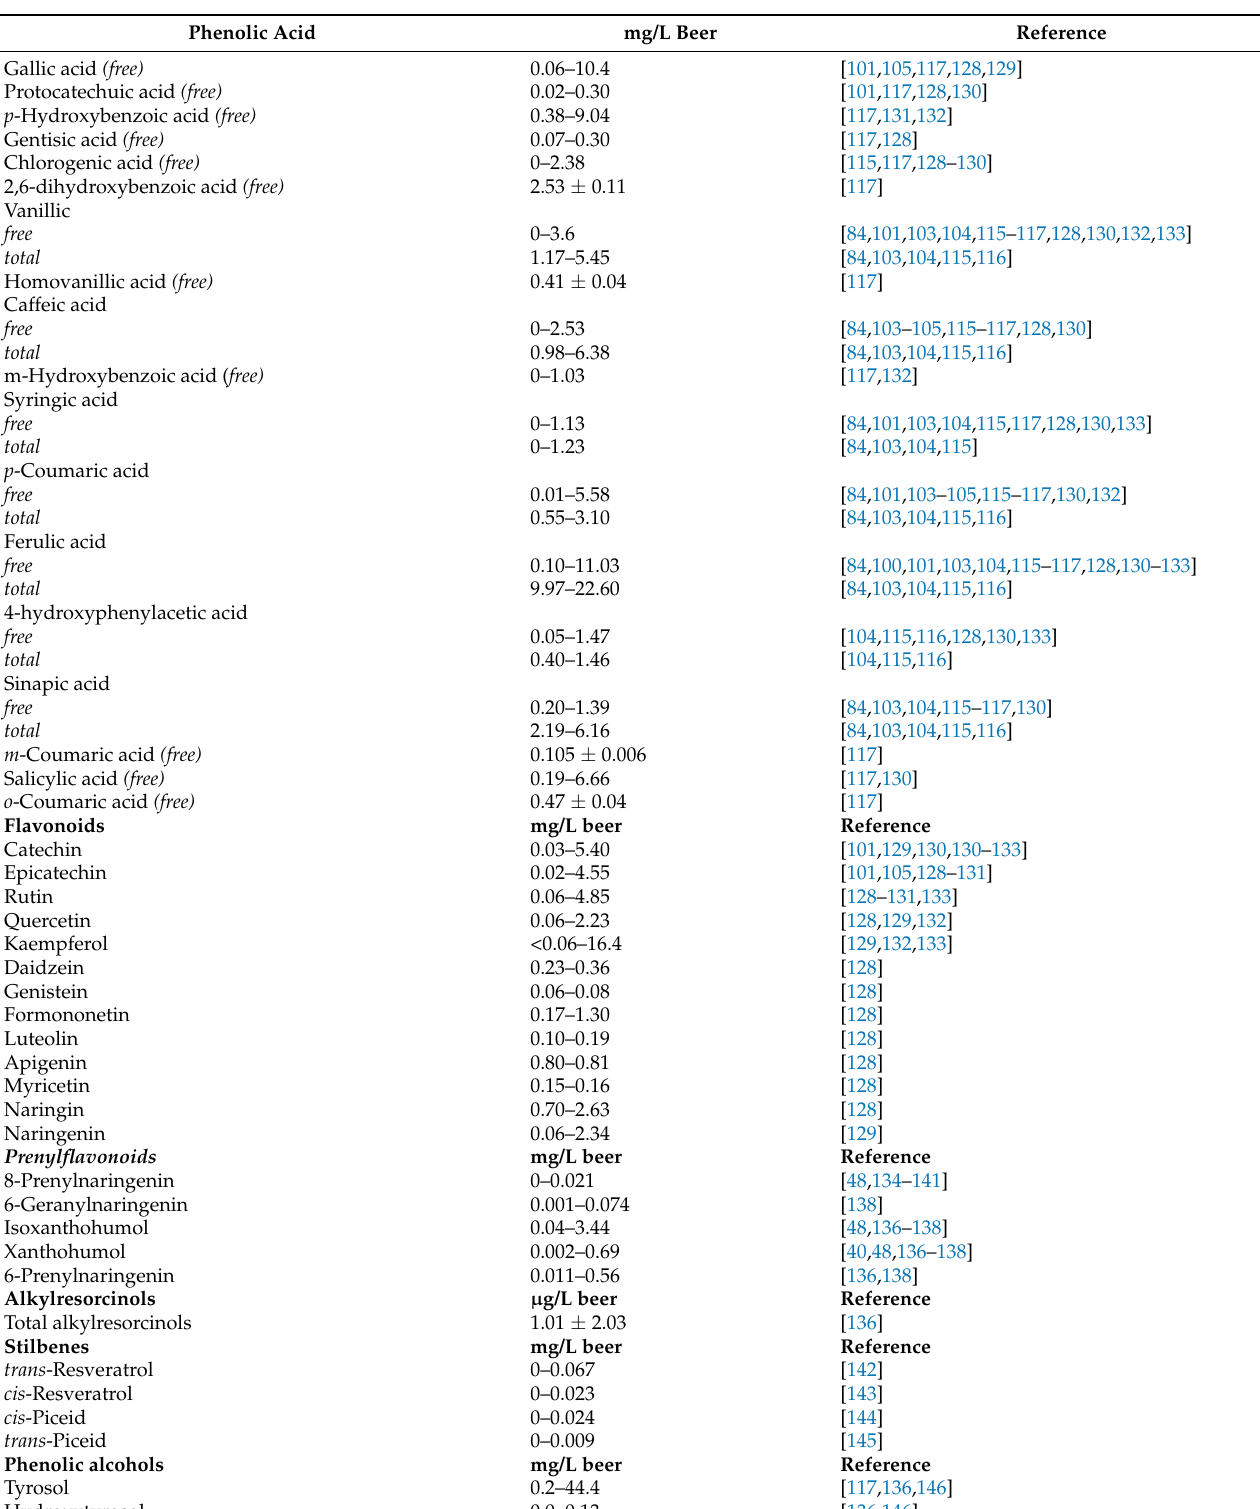
Table 2. Bioactive compounds in conventional